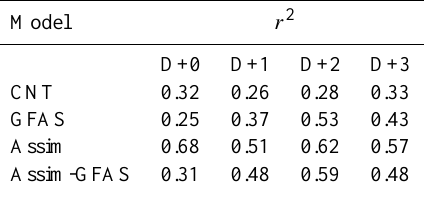
Table 8. Temporal correlation (r 2 ) of modeled total CO columns (units 10 18 molec cm − 2 ) with respect to ground-based CO total col- umn observations at the Moscow and Zvenigorod stations between 20 July and 15 August ( n = 21), as function of the hindcast